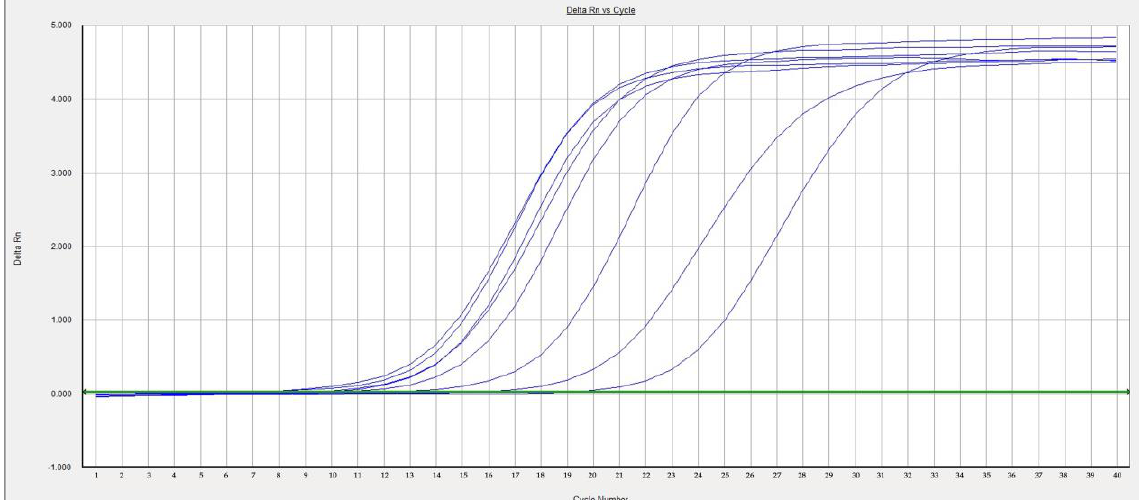
Figure 5. Detection of avian orthoreovirus via real-time RT-PCR.